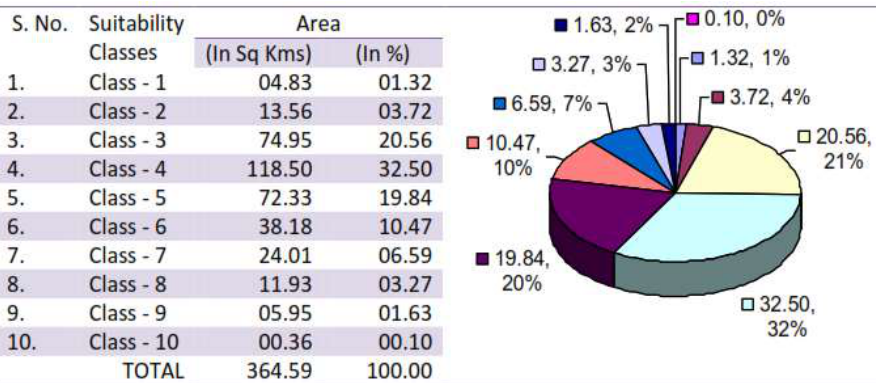
Table 1. Table of Area of Conformity of Tourism Development